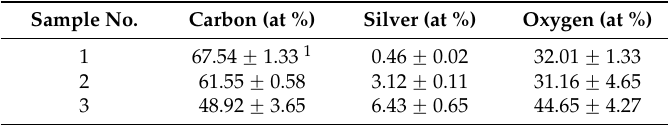
Table 1. Averaged DLC:Ag chemical composition obtained with EDS. Sample No.